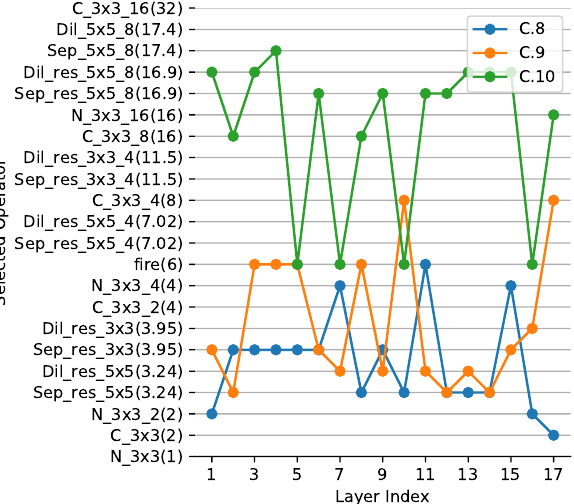
Figure A1. The operator of each layer in compressed VGG16. The layers in the figure do not include the first convolutional layer and the last fully connected layer. The vertical axis have the same meanings as Figure 5.